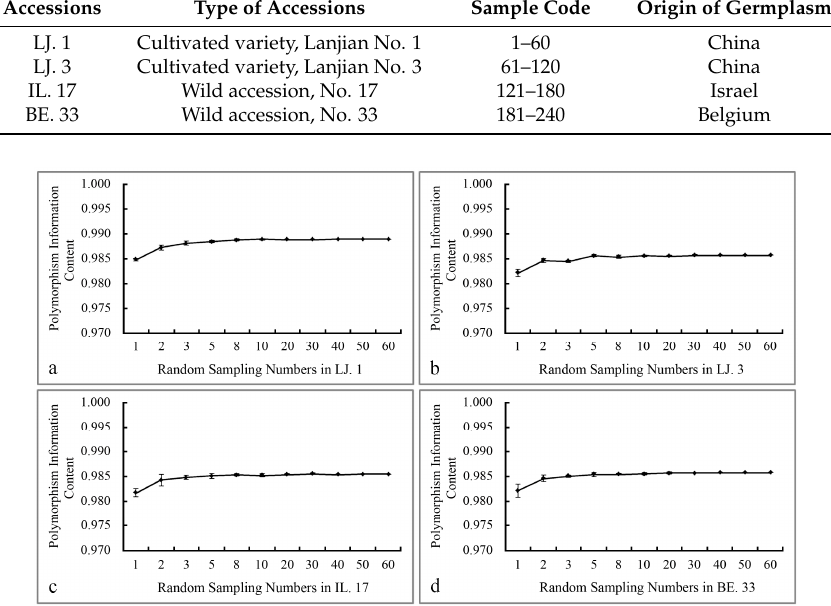
Figure 1. Polymorphism Information Content of the four accessions at different sampling sizes. ( a ) LJ. 1; ( b ) LJ. 3; ( c ) IL. 17; ( d ) BE. 33. Table 2. Expected heterozygosity ( H E ), the observed number of alleles ( Na ) and the Reserve Percentage (RP) at different sampling sizes of the four accessions.